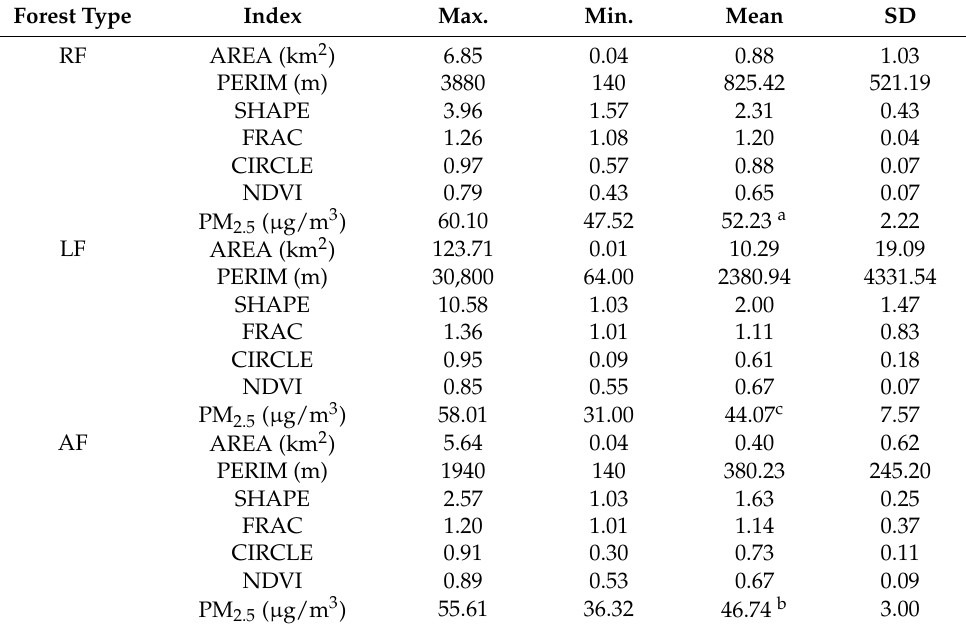
Table 2. Descriptive statistic of forest patch characteristic parameters and PM 2.5 concentration of three forest